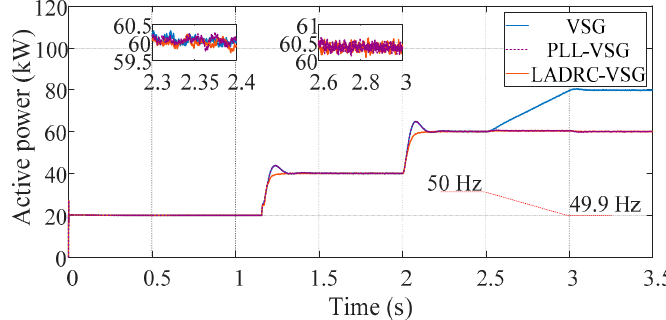
Figure 21. Output power of VSG under different control strategies.